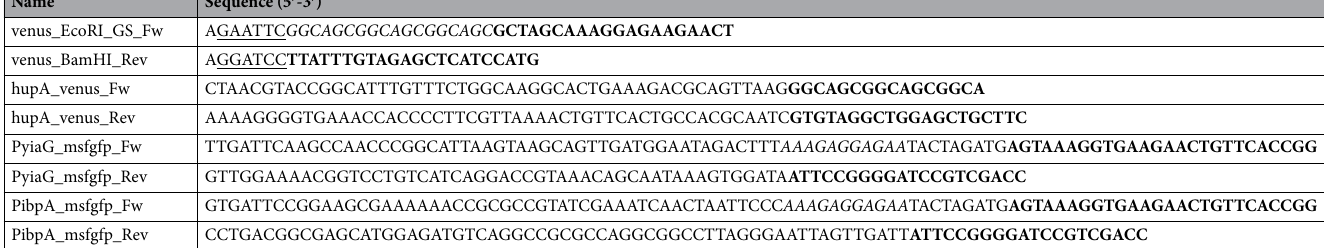
Table 1. Primers used in this study. Primer attachment sites are indicated in bold, linker sequences and artificial ribosome binding sites in italics , and restriction sites are